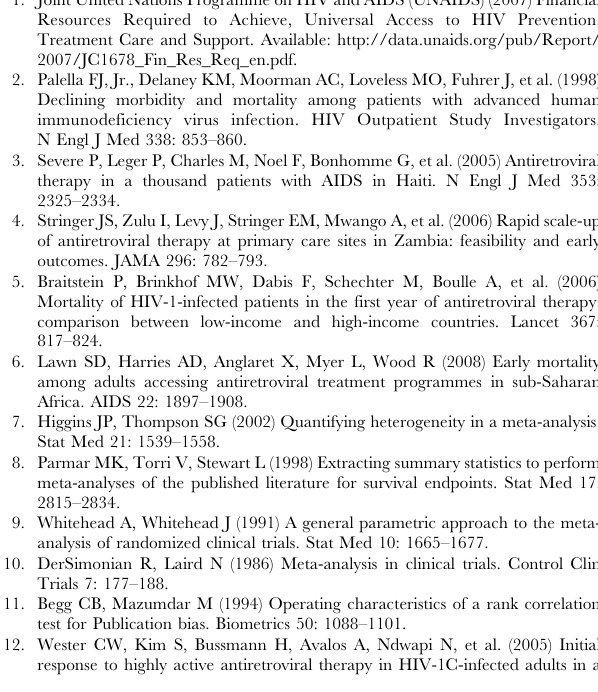
Table S1 Exact search terms. The final search strategy was the combination of search terms 1, 2 and 3. Table S2 Characteristics and mortality data from all studies of patients initiating ART in low- and middle- income countries grouped by region and by method of death reporting. F = female; IQR = Inter quartile Range; CD4 cell count = cells/mm 3 ; SD =Standard deviation; PY =Person Years; Two studies had a mix of active and passive follow-up among their clinics. However, studies defined lost to follow-up in various ways and used different methods for tracing participants. 1 = Two studies used passive reporting and 11 active tracing, latter of which included home visits/community visits (n= 9), phone calls (n =4) and letters (n =2); others did not specify; # = Mul- ultivariable analysis of risk factors of death performed. Table S3 Studies assessing independent risk factors for early mortality organized by measure of association and by region. V only those measures of association reaching statistical significance in multivariate analysis are included; BMI = Body Mass Index. All BMI values are baseline and in kg/m 2 unless mentioned otherwise; CD4 =CD4 cell count. All CD4 counts are baseline and in cells/mm 3 unless mentioned